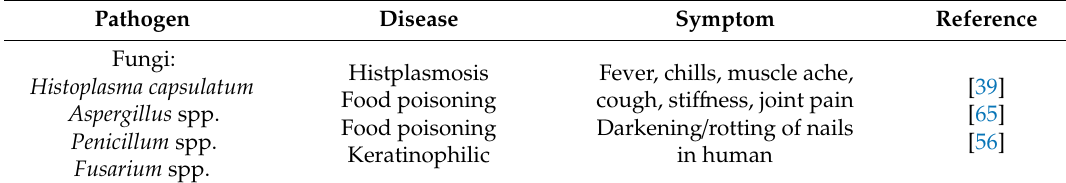
Table 4. Fungi, helminthes, protozoa, and viruses in chicken litter and their health e ff